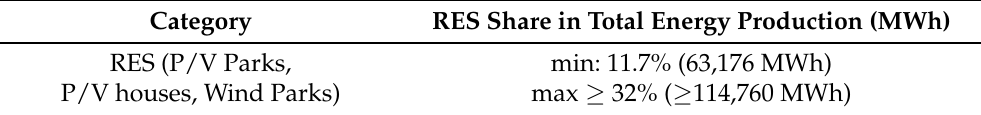
Table 11. Renewable Energy Sources percentage share in Total Energy